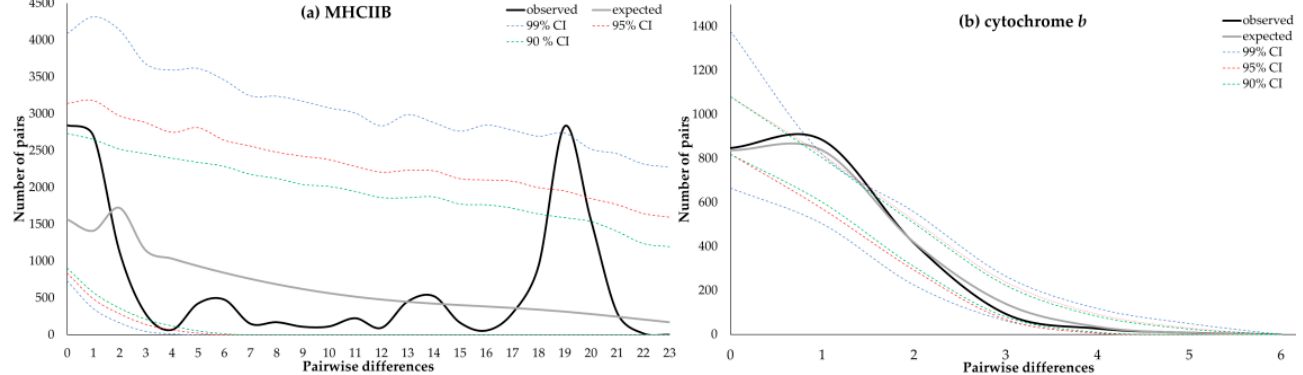
Figure 6. Mismatch distributions show the observed and expected frequencies of pairwise nucleo- tide differences from MHCIIB and cytochrome b haplotypes for 68 Heermann’s Gull individuals. Confidence intervals were 90% (green), 95% (red), and 99% (blue). ( a ) Multimodal distribution drawn for MHCIIB is consistent with the demographic equilibrium rather than expansion. ( b ) Con- versely, the unimodal distribution depicted for cytochrome b is typical in populations with a recent demographic expansion.